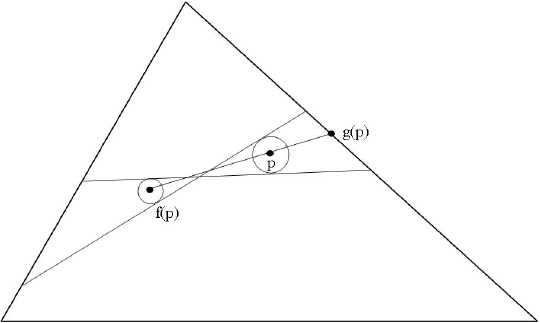
Figure 3. The first proof of the Brouwer